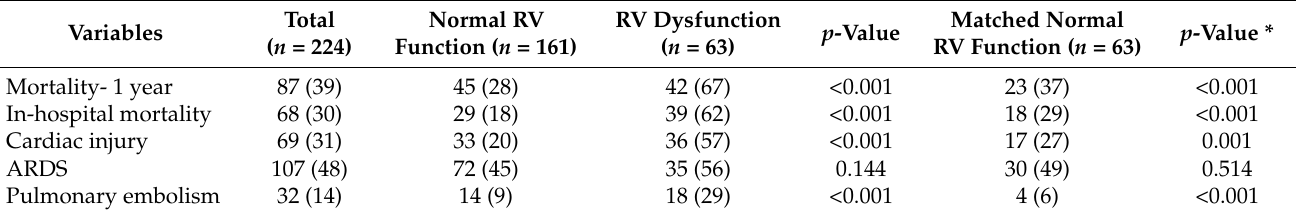
Table 2. Clinical outcome of study